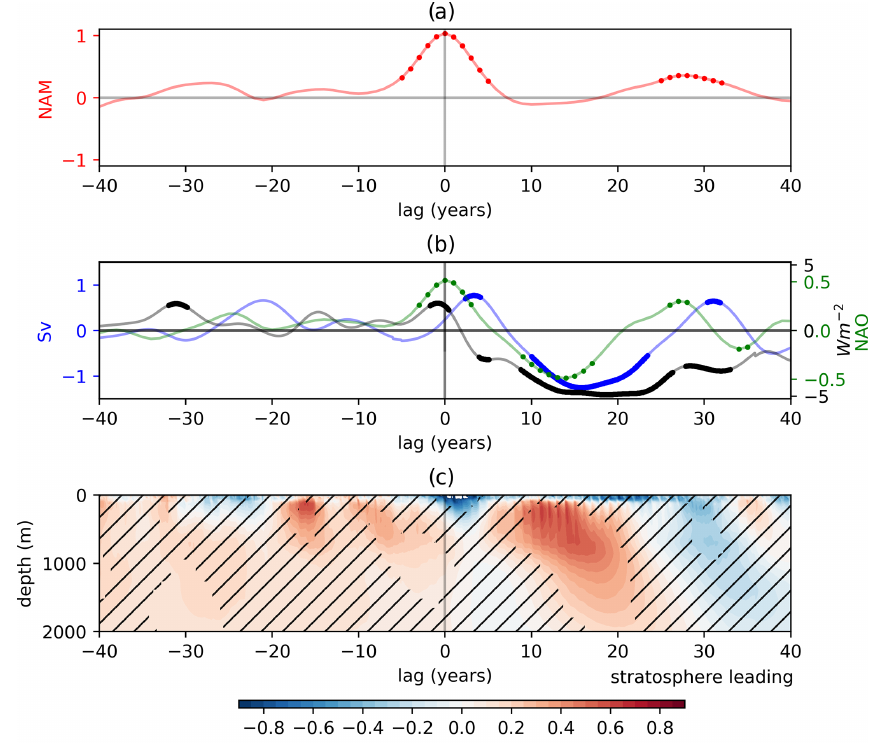
Figure 4. (a) Composite differences in the smoothed NAM 10 index around extreme NAM 10 intervals (positive minus negative intervals). (b) As in Fig. 3f but for the AMOC at 50 ◦ N (blue), the Dec–Mar mean NAO index (green) and the ocean–atmosphere heat flux (sum of latent and sensible fluxes; black) are averaged over an Atlantic box defined by 45–65 ◦ N, 15–60 ◦ W. All indices are smoothed with a Gaussian filter ( σ = 2 years). (c) Lagged responses of the ocean temperature anomaly depth profiles to persistent NAM 10 intervals. Composite differences between strong and weak intervals are shown for the same Atlantic box as the heat flux index. Hatching indicates composite differences that are not significant at the 95% level under a two-tailed Student’s t